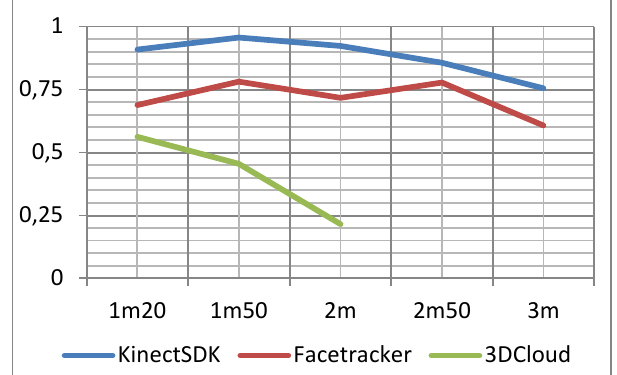
Figure 16. Mean correlation for the yaw function of the viewer distance from TV (in m).